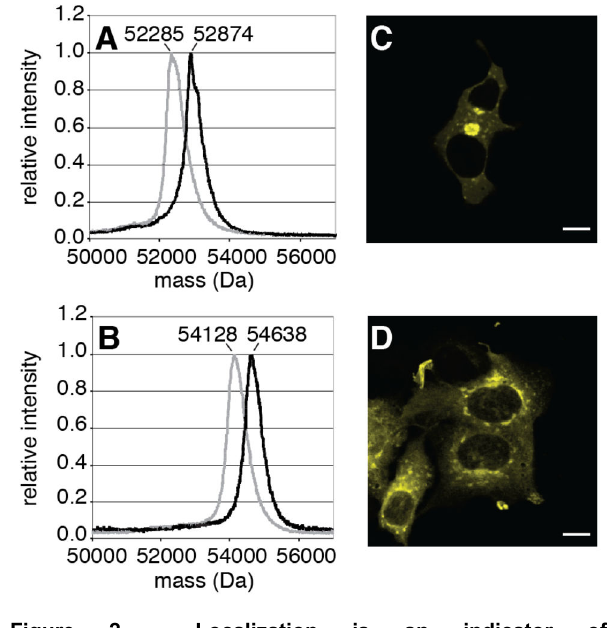
Figure 2. Localization is an indicator of